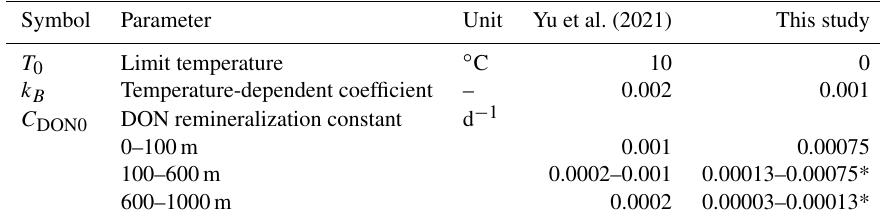
Table C1. Comparisons in biogeochemical